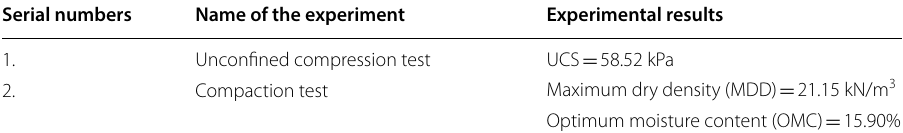
Table 3 Experimental results of mechanical properties for unreinforced soil